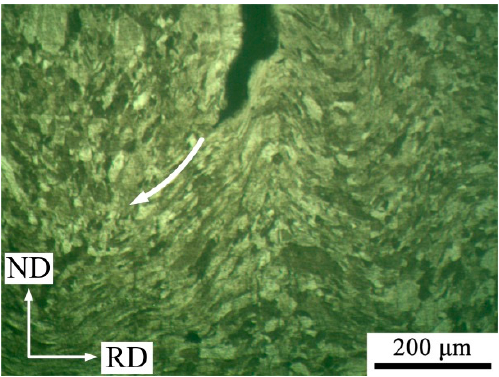
Figure 4. Micro-crack propagation of CGP nickel sheets after pass 3 in scheme 3.